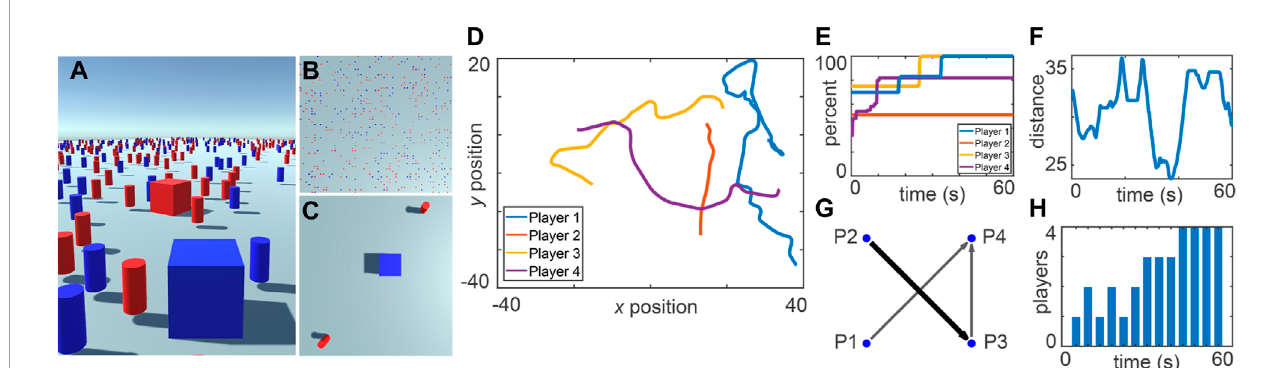
FIGURE 1 Collective decision making. Participants control cubic avatars while having either a broad (A) or limited (C) view of the full environment (B) . A wide variety of variables can be measured during the experiment, such as the participants’ trajectories (D) , the percentage of the environment they have explored (E) , the average distance between participants (F) , the participant-participant viewing network (G) , and the number of avatars choosing the correct color (H) . Figure reprinted by permission from Springer Nature Customer Service Centre GmbH: Springer eBook, Coucke et al. (2020), © Springer Nature 2020.